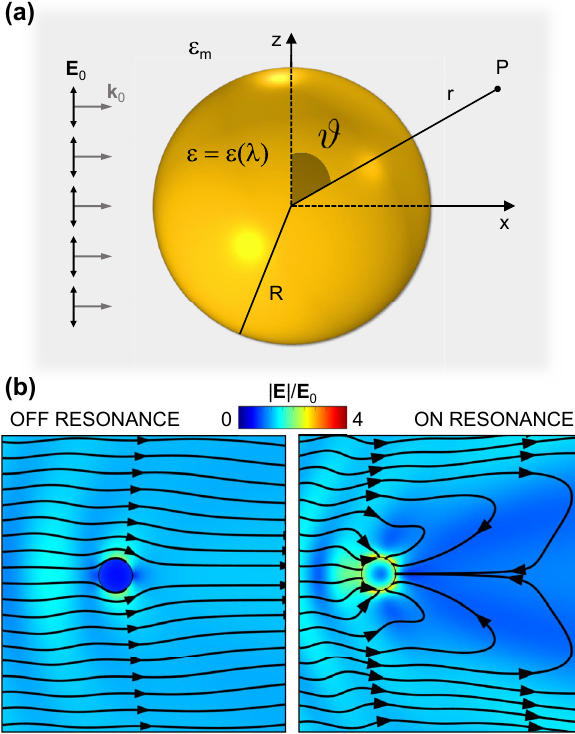
Figure 1: Localized surface plasmon resonance in small NPs. (a) Sketch of a metal spherical NP of radius R and permittivity 𝜀 , embedded in a homogeneous dielectric medium of permittivity 𝜀 and subjected to an m linearly polarized along the z -axis. electrostatic field of amplitude E 0 (b) Electric field enhancement (colour map) and field lines of the total Poynting vector (excluding that scattered) around a small ( R = 60 nm) Ag NP in air, off resonance (left, 𝜆 = 600 nm) or on resonance (right, 𝜆 = 346